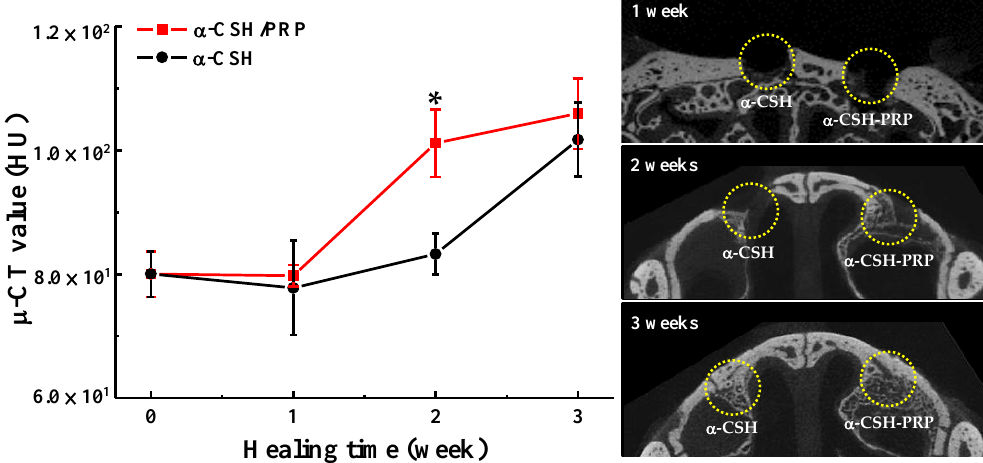
Figure 2. HU values and µ-CT images of the sinuses defect at 0, 1, 2, and 3 weeks after treatment with α-CSH and α-CSH/PRP bone graft samples. (HU was obtained by determining the intensity of gray area in the ROI of µ-CT image (yellow circular area)). Week 0 is the defect area without bone graft, which to be used as the reference value. A lower intensity of gray area in the ROI was detected in both samples at week 1. The α-CSH/PRP sample exhibited higher intensity of gray area as compared with α-CSH sample at week 2 (* p < 0.05). Both samples presented similar intensity of gray area at week 3. The intensity of gray area in the ROI increased with healing time increasing.